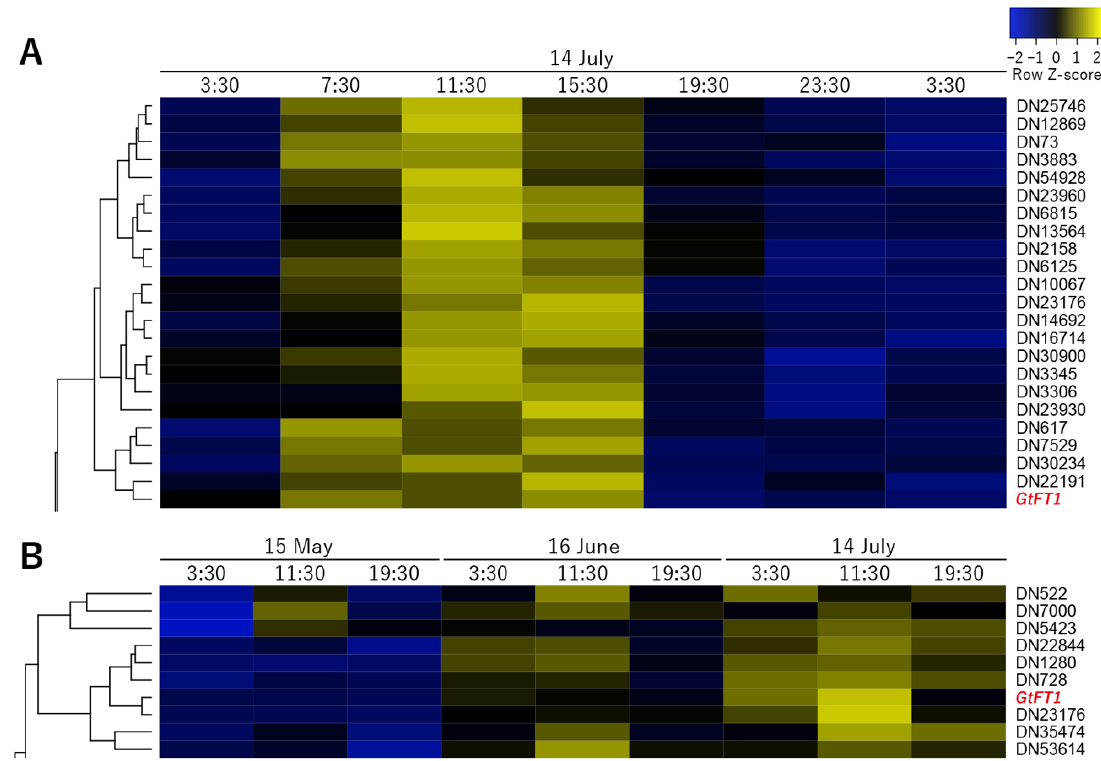
Figure 6. Coexpression cluster analysis of transcription factor genes coexpressed with GtFT1. ( A ) Clustering analysis was performed using the TPM values from 14 July, as described in the Materials and Methods. ( B ) Clustering analysis was performed using the TPM values from three months, as described in the Materials and Methods. Table 4. Coexpressed transcription factor genes with GtFT1 during development over three months.